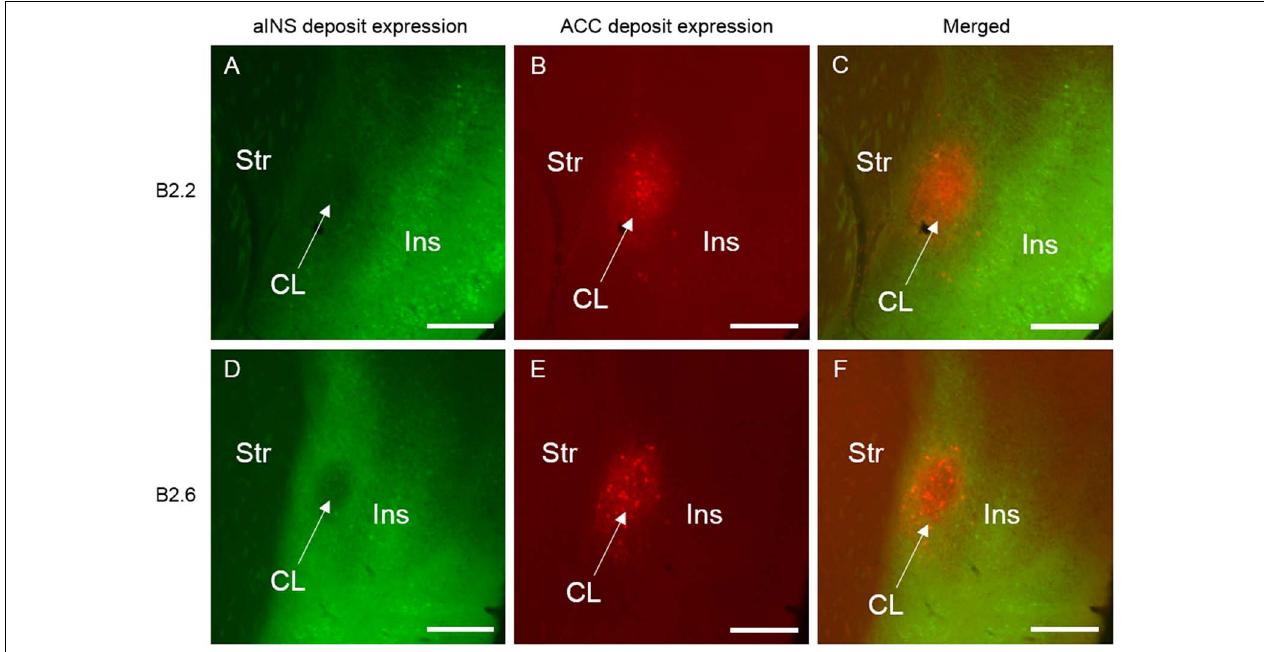
FIGURE 4 | Selected photomicrographs of the rostral level of the claustrum and surrounding regions illustrating retrograde and anterograde labeling following aINS and ACC viral injections (AP = + 1.10 mm from bregma) for case B2.2 (A–C) and B2.6 (D–F) . Dense retrograde and anterograde labeling in the insular cortex, endopiriform nucleus, and piriform areas is shown following viral injection in aINS for both cases (A,D) . Retrograde and anterograde labeling of the claustrum following deposit into the ACC (B,E) . Merge of panels (A) and (B) is shown in (C) . Merge of (D) and (E) is shown in (F) . Scale bar: 500 µ m. Str, striatum; CL, claustrum; Ins, insular cortex.